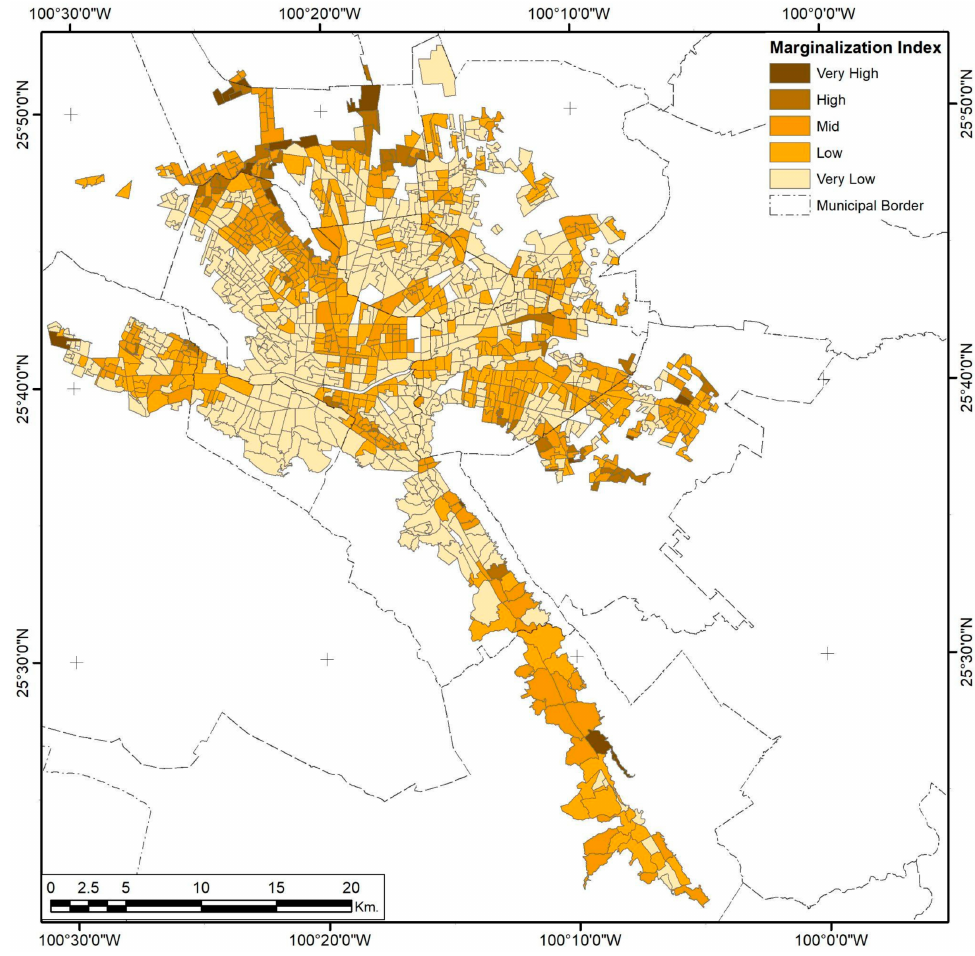
Figure 11. Monterrey City Urban Marginalization Index (UMI) by AGEB. Developed by the authors with data from